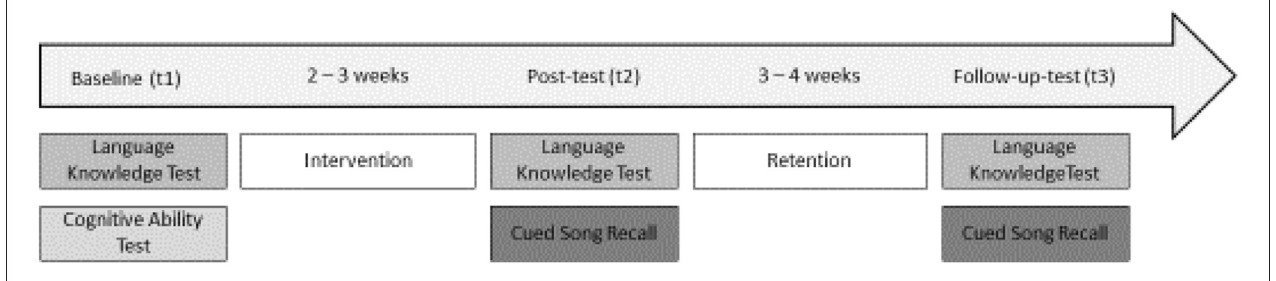
FIGURE 1 | Overview of study